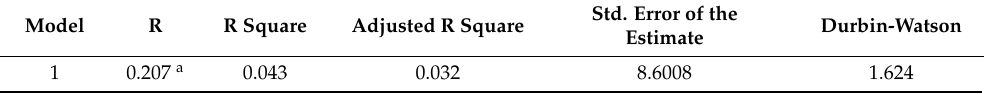
Table 12. OC and the ITG model summary b .